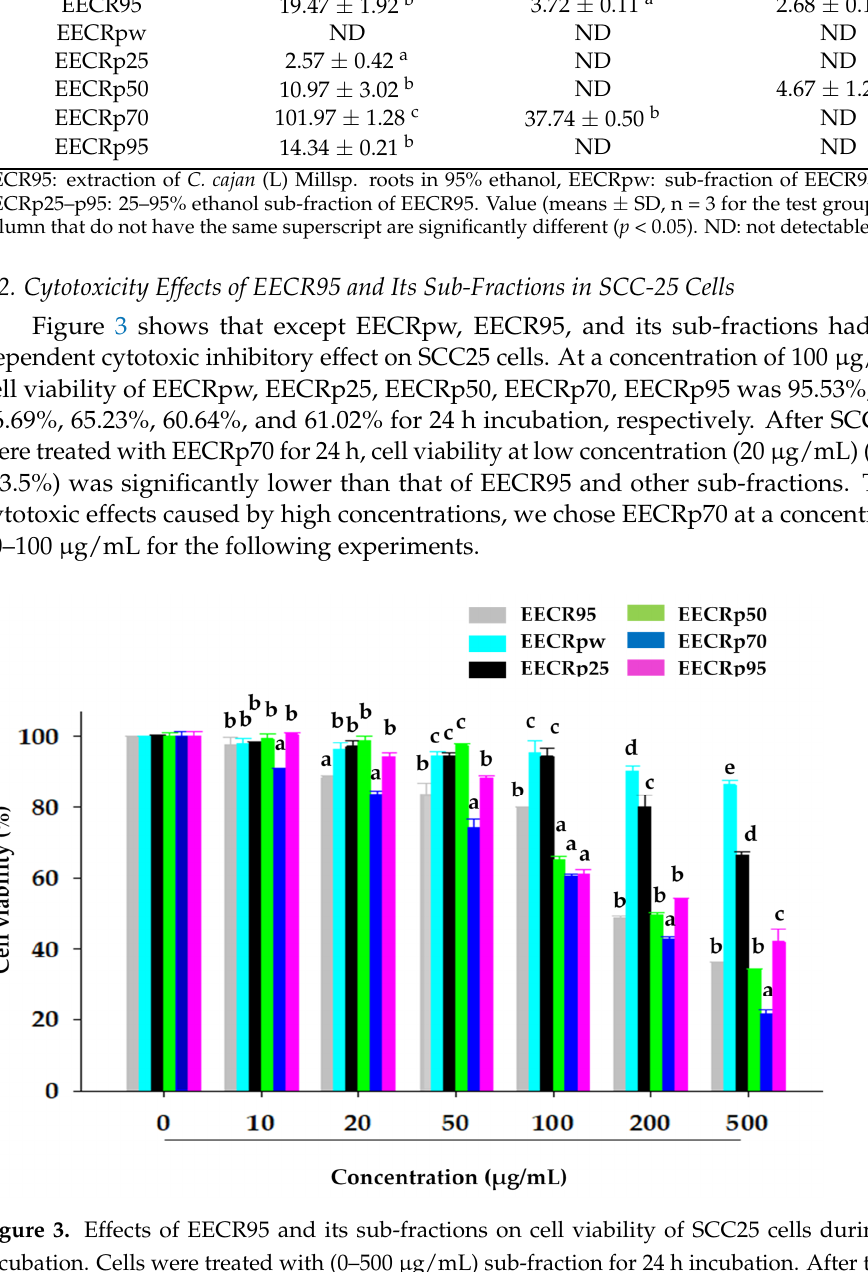
Table 1. The contents of flavonoids of EECR95 and its sub-fractions. Flavonoids (mg/g) Sub-Fractions Genistein